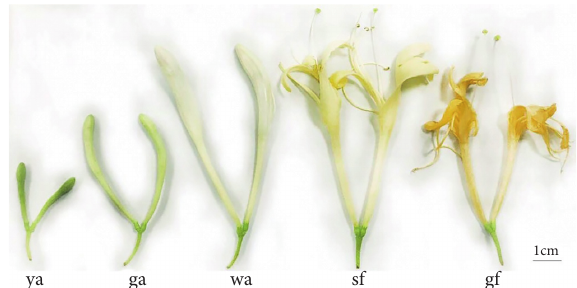
Figure 1: Sample characteristics of Lonicera japonica in five